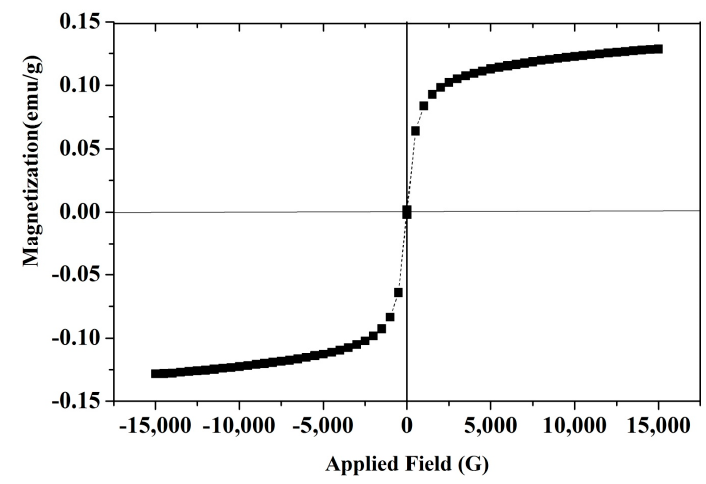
Figure 5. Magnetization curves of Fe 3 O 4 /AC/CD/Alg polymer composite gel beads at room temperature.